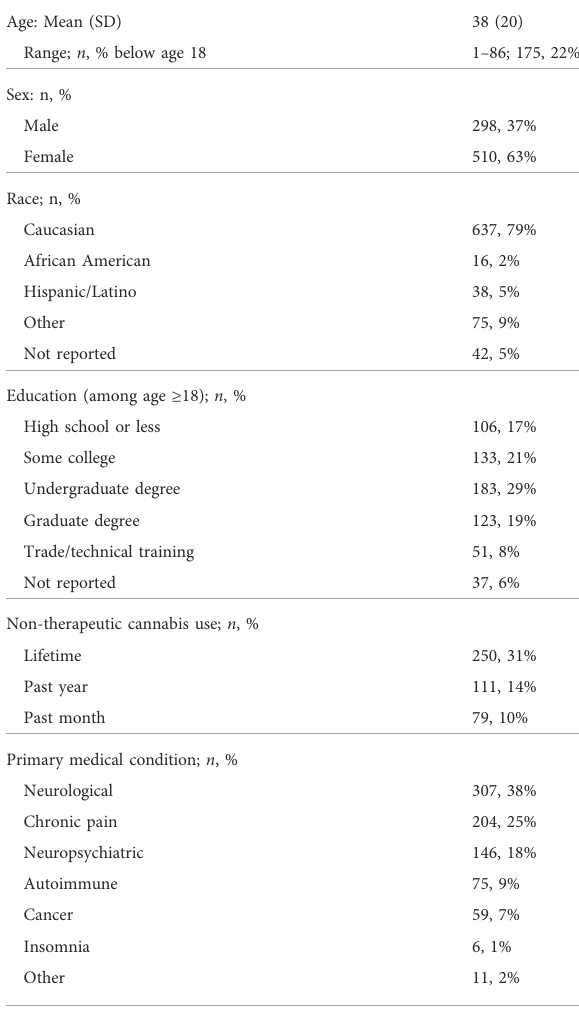
TABLE 1 Participant demographics ( N =